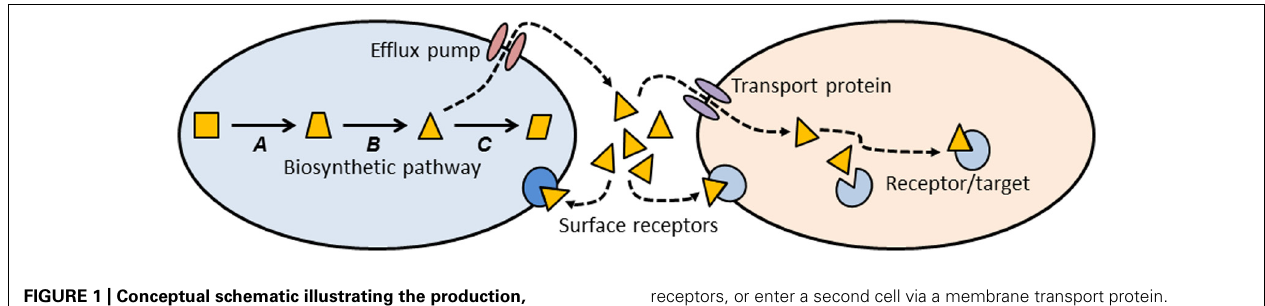
FIGURE 1 | Conceptual schematic illustrating the production, export, and target sites of a small molecule biosynthetic cluster. The metabolic pathway for synthesis of a small molecule is encoded by genes A , B , and C . One of the intermediates (triangle) is exported from the cell via an efflux pump, where it can then bind to cell surface